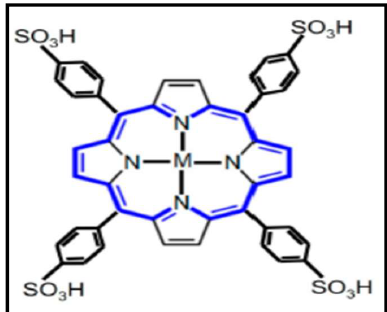
Figure 3. Typical structure of meso-sulphonatophenyl porphyrin which can be used as a contrast agent for magnetic resonance imaging (MRI) (M = Mn(III), Fe(III), and Cu(II) [5].